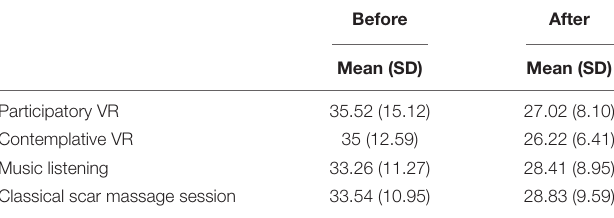
TABLE 6 | Means and standard deviation of anxiety by experimental condition as a function of the time of